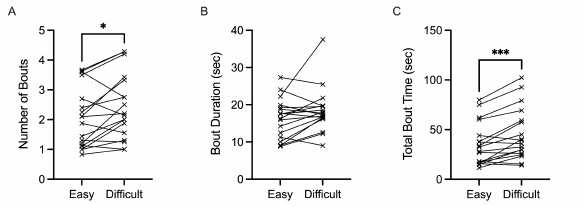
Figure 7. Individual data points for number of bouts (A), bout duration (sec) (B), and total bout time (sec) (C) are demonstrated for easy and difficult conditions. * p ≤ 0.05, ** p ≤ 0.01, *** p ≤ 0.001, **** p ≤